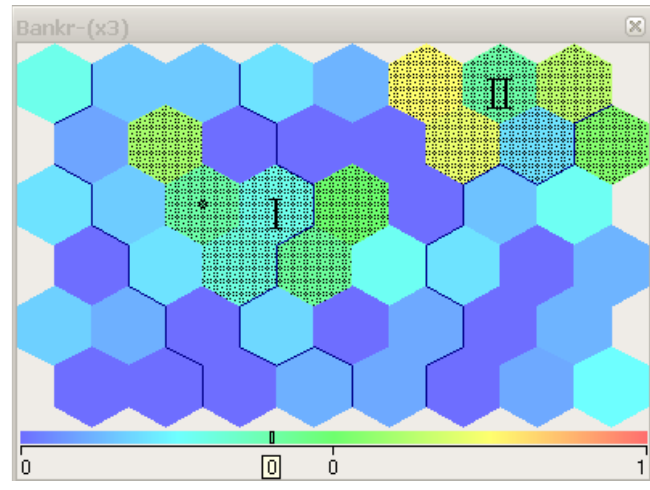
Figure 2. SOM (2014–2017). Local zones on the bank solvency